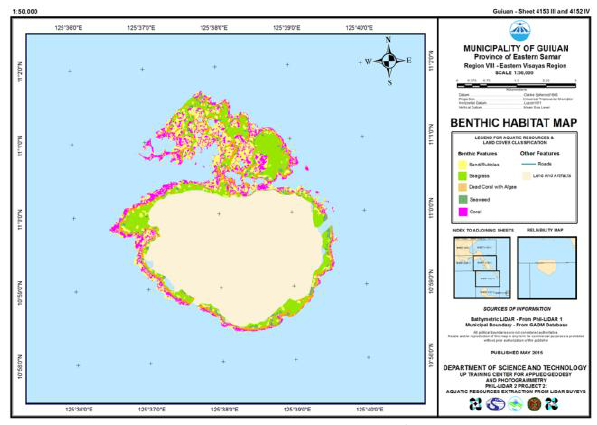
Figure 2. Sample Benthic Habitat Map of Manicani Island, Guiuan, Eastern Samar from LiDAR data